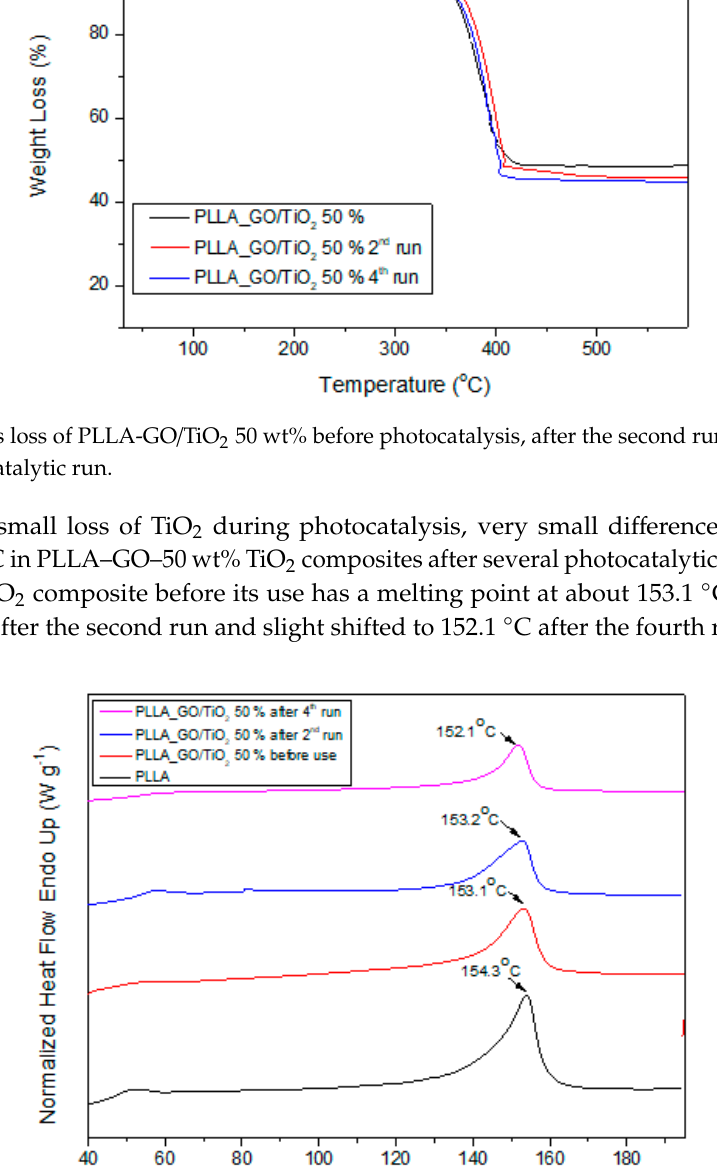
Figure 8. SEM micrographs of PLLA-GO/TiO 2 50 wt%: ( a ) before photocatalysis, ( b ) after the second run and ( c ) after the fourth photocatalytic run.